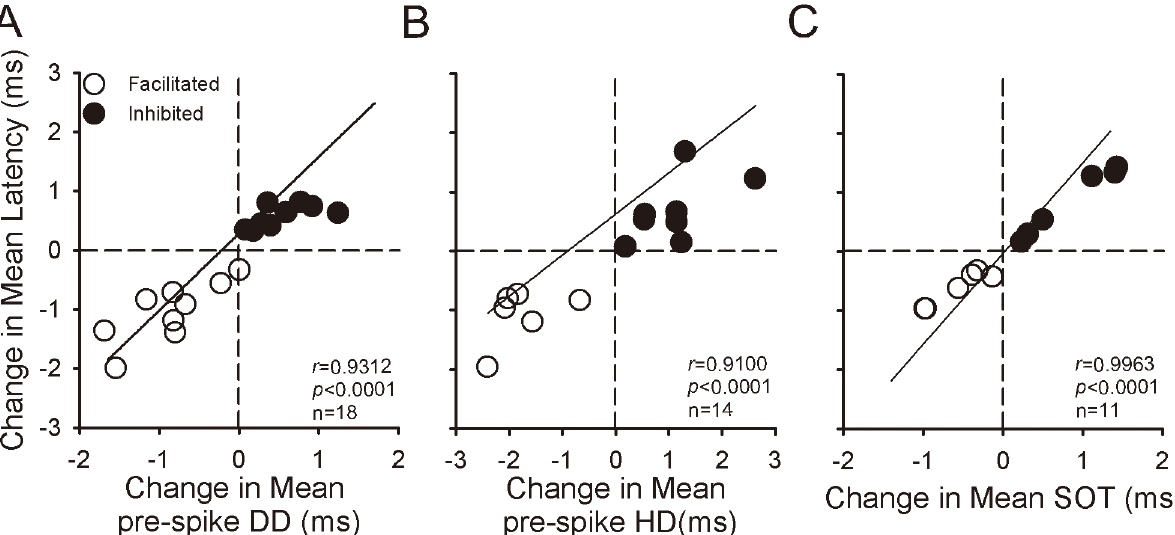
Fig 8. Relation between latency change and pre-spike DD, pre-spike HD, and SOT change of IC neurons. (A) Latency decreasing and increasingwith pre-spike DD shorteningand lengthening inducedby descending facilitation(unfilledcircle) and inhibition (filled circle) activated by AC ES , respectively ( r = 0.9312, p < 0.0001). (B) Latency decreasing and increasingwith pre-spikeHD shorteningand lengtheninginducedby descending facilitation (unfilledcircle) and inhibition(filled circle) activated by AC ES , respectively( r = 0.9100, p < 0.0001). (C) Latency decreasing with SOT forward shift inducedby descending facilitation (unfilledcircle) activated by AC ES and vice versa (filled circle) ( r = 0.9963, p < 0.0001). The solid lines in A, B, and C are regression